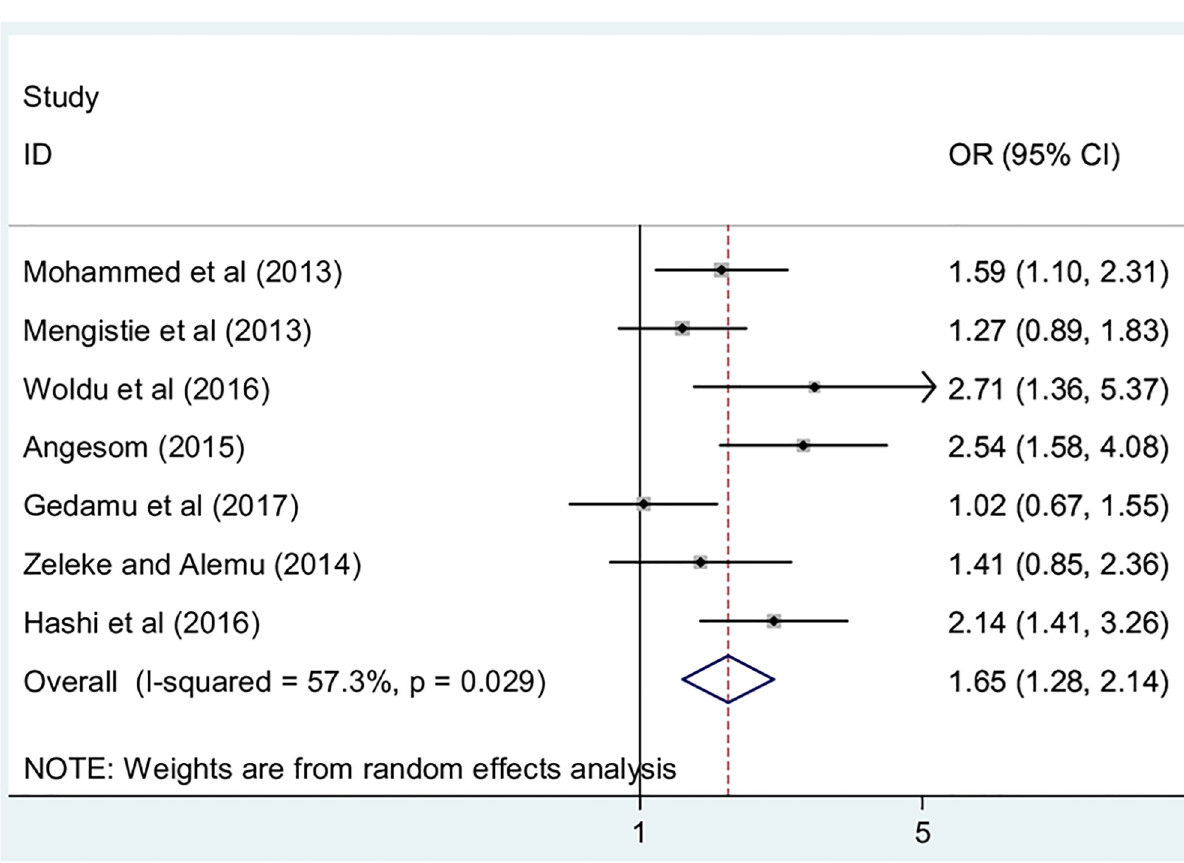
Fig 4. The pooled odds ratio of the association between maternal education and childhood diarrhea in Ethiopia.